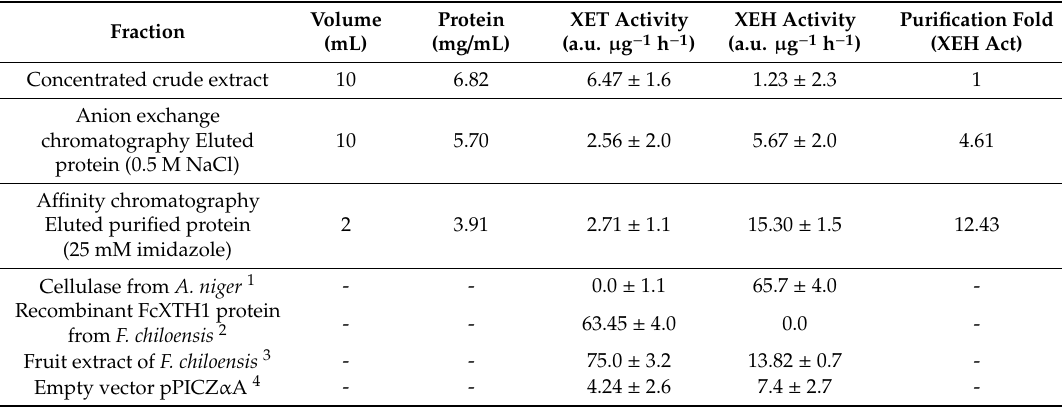
Table 1. Purification of recombinant FcXTH2 protein expressed in P.